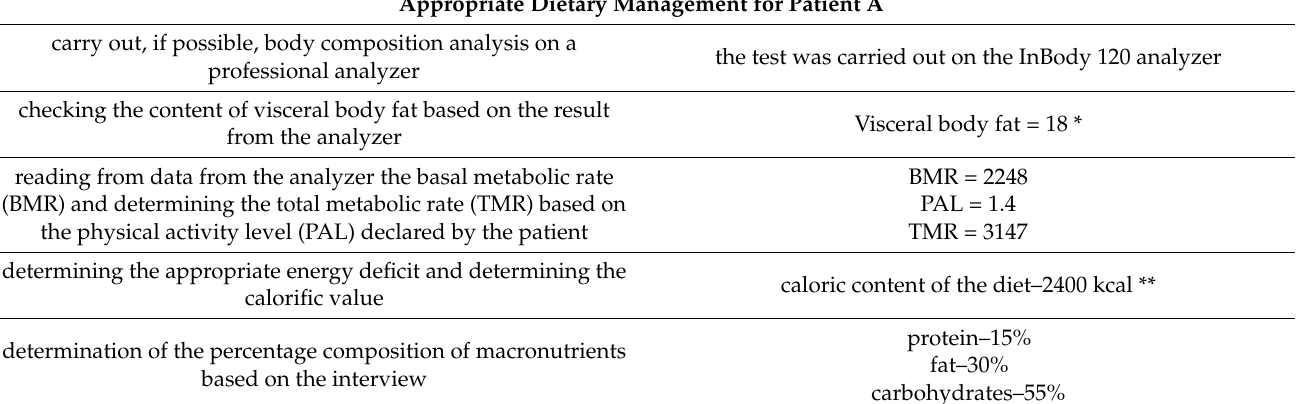
Table 6. Appropriate dietary management for Patient A. Appropriate Dietary Management for Patient A